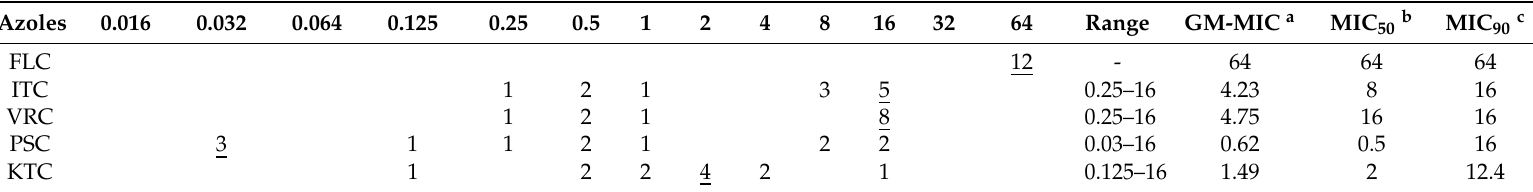
Table 2. MIC distribution of the C. haemulonii species complex ( n = 12 isolates) against five azole agents tested using the CLSI standard